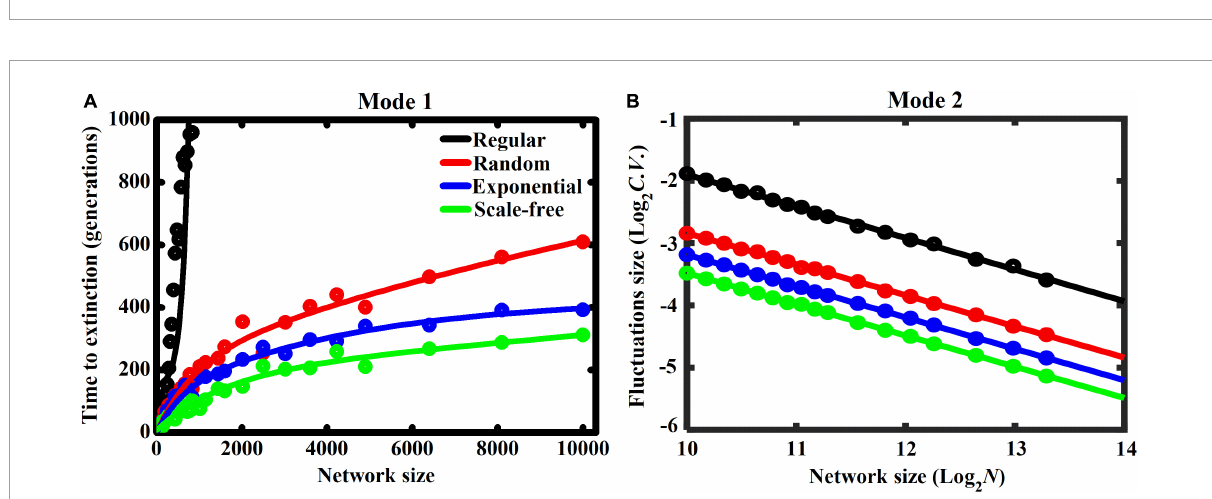
FIGURE5 Effect of network size ( N ) on ecosystem stability under Modes 1 & 2 in networks with contrasting heterogeneities, including lattice-structured regular, randomly connected, exponential, and scale-free networks (each dot represents the mean of 20 replicates). Stability is characterized by panel ( A : Mode 1) the time (generations) required for the first species going extinct, or ( B : Mode 2) the coefficient of variation (C.V.) in fluctuations size around the mean species abundances at steady state. More time required for species extinction or lower values of C.V. indicates a more stable